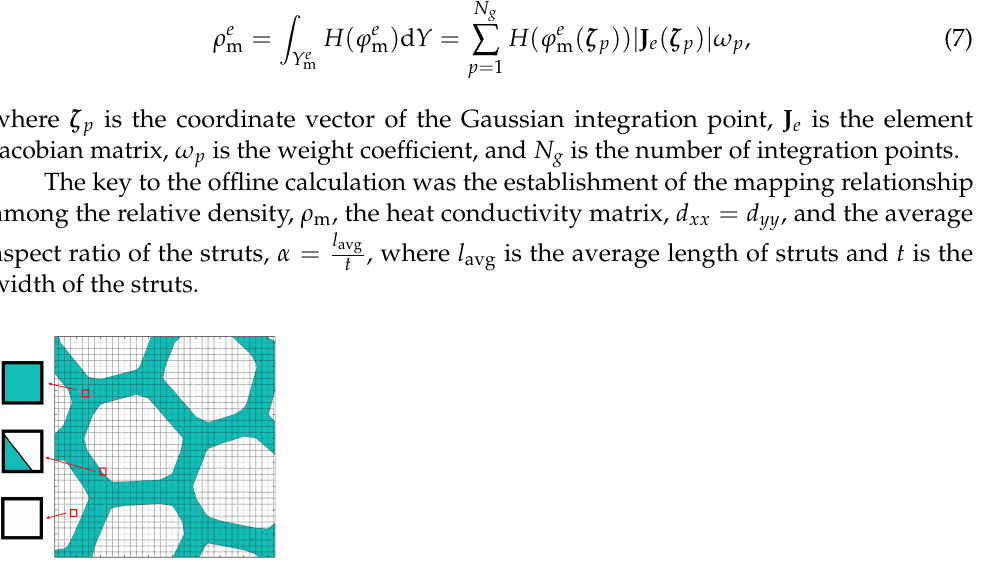
Figure 3. Illustration of the background grid and three types of